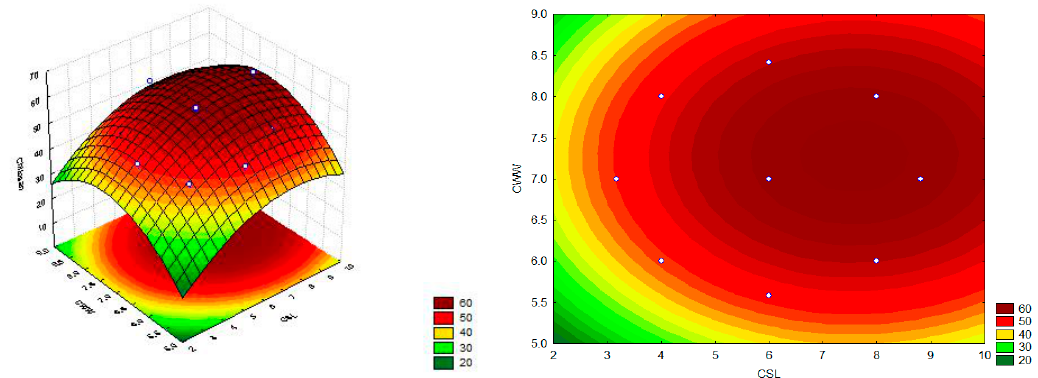
Figure 7. Response surface graphs of the chitosan production by L. hyalospora (UCP 1266) grown in medium formulated with CSL and CWW for 120 h at 28 °C.